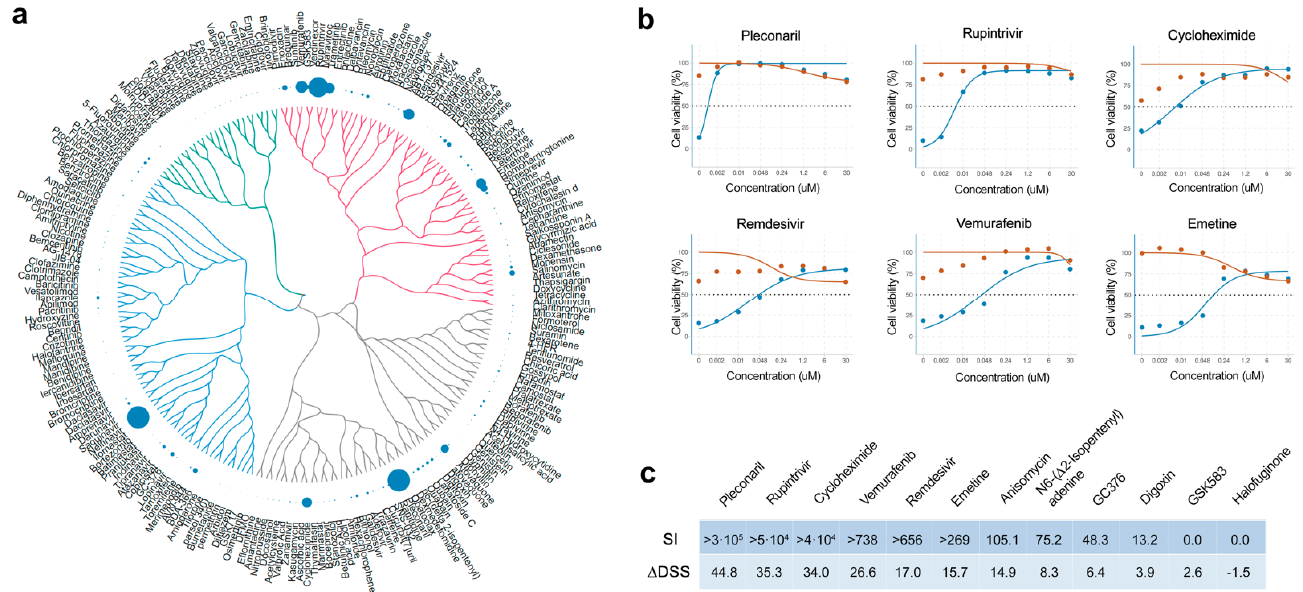
Figure 1. Anti-EV1 activity of 239 broad-spectrum antivirals (BSAs) in A549 cells. ( a ) Structure–antiviral activity relation of BSAs. A549 cells were treated with increasing concentrations of a compound and infected with the EV1 (moi, 0.1). After 48 h, the viability of the cells was determined using the CellTiter-Glo (CTG) assay. The anti-EV1 activity of the compounds was quantified using the drug sensitivity scores (DSS) and shown as bubbles. Bubble size corresponds to compounds DSSs. The compounds were clustered based on their structural similarity calculated by ECPF4 fingerprints and visualized using the D3 JavaScript library. ( b ) Validation of anti-EV1 activity of hit compounds in A549 cells. A549 cells were treated with increasing concentrations of a compound and infected with the EV1 (moi, 0.1: blue) or mock (red). After 48 h, the viability of the cells was determined using the CTG assay. Mean ± SD; n = 3. Plots for 6 most effective BSAs are shown. ( c ) Table showing selectivity indexes (SI = CC50/EC50) and Δ DSS for selected BSAs.